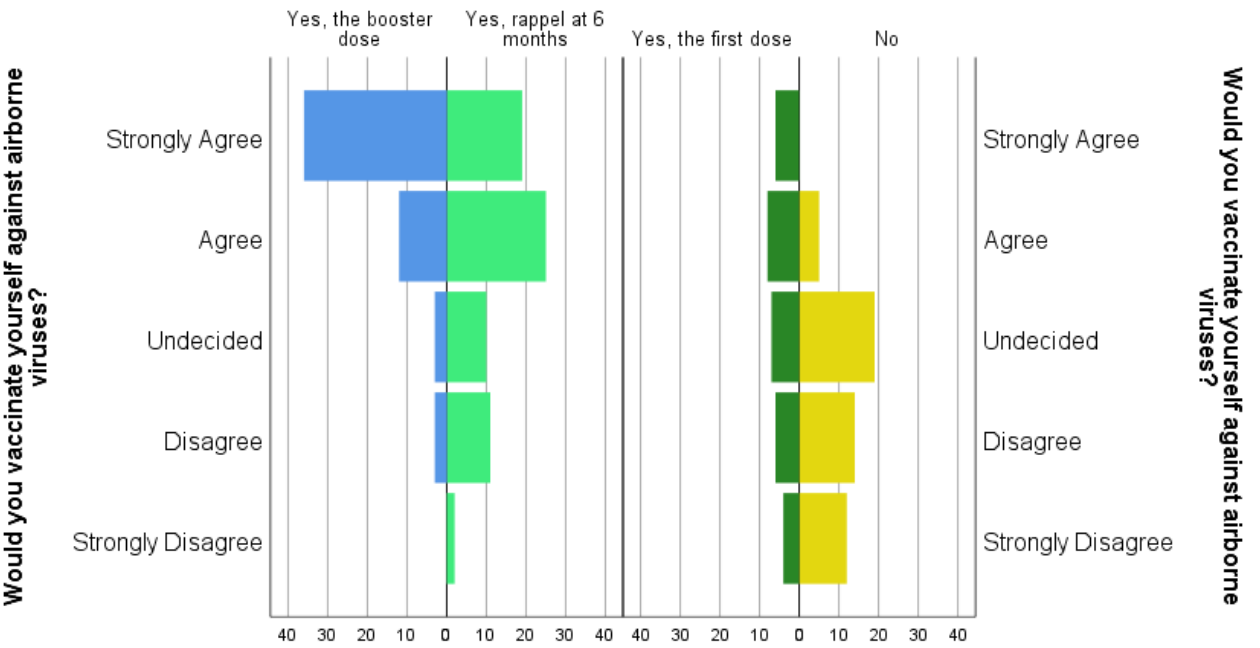
Figure 3. Subjects Pyramid Count “Would you vaccinate yourself against airborne viruses?” by “Have you been vaccinated against SARS-CoV-2?” The colors code is: Blue – Yes, the booster dose; Light green – Yes, rappel at 6 months; Dark green – Yes, the first dose; Yellow - No. Although the TB vaccine is mandatory in Romania, 36.14% (73) do not know if they have had it, 35.15% (78) declared that they did not have it and 28.71% (58) declared that they did have it ( p > 0.05) (Table 4). 4. Discussion Based on the analysis of our results, we can find a majority participation in the study of people aged between 18 and 40 years. This aspect could be justified based on the place where the study was carried out, namely the online environment, the Google Docs plat- form. Younger people show a much greater interest in online platforms. Additionally, the people from the urban environment seemed more interested in contributing to the reali- zation of the study. Airborne infections represent a category of diseases with a very high level of importance. 4.1. Assessment of the Level of Knowledge Regarding the Transmission of Infection by Air Aerosols represent a means of contamination in dental offices. Due to the fact that there is a direct correlation between respiratory system infections of dental staff and the concentration of aerosols in the office, patients must declare any respiratory disease [25]. Contaminant particles in the air can remain on surfaces or move according to the air flow [26,27]. Thus, air decontamination is a very important measure in infection control [28]. The dental office must be naturally ventilated for at least 15 min after each patient and the UV lamp activated according to its instructions for use [1]. A similar study conducted by King Abdulaziz University in Saudi Arabia highlights that most participants agreed that during treatment dentists should wear gloves (98.2%), protective mask (96.9%) should replace gloves after receiving a phone call (80%) and not use them for another patient (89.8%) [29].